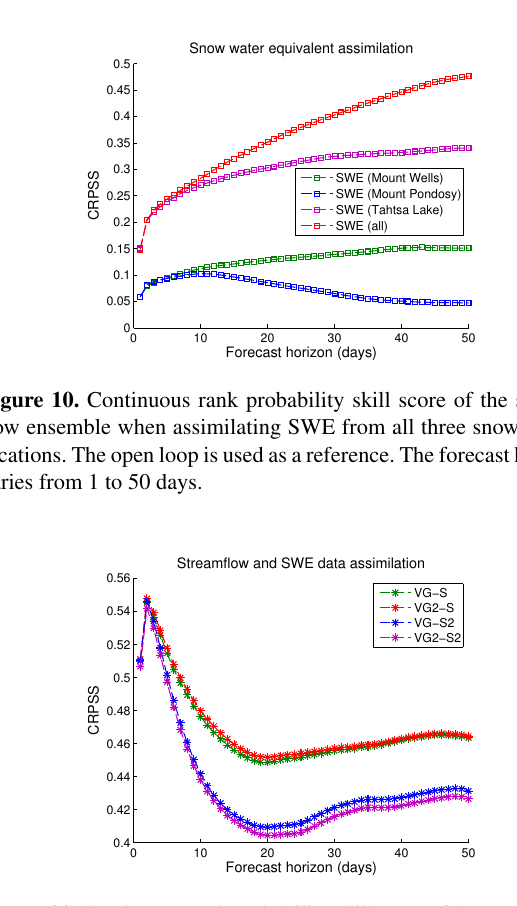
Figure 11. Continuous rank probability skill score of the streamflow ensemble when assimilating streamflow at the outlet and SWE from all three snow pillow locations. The open loop is used as a reference. The forecast horizon varies from 1 to 50 days. Lack of parentheses indicates that the variable is affected by both types of